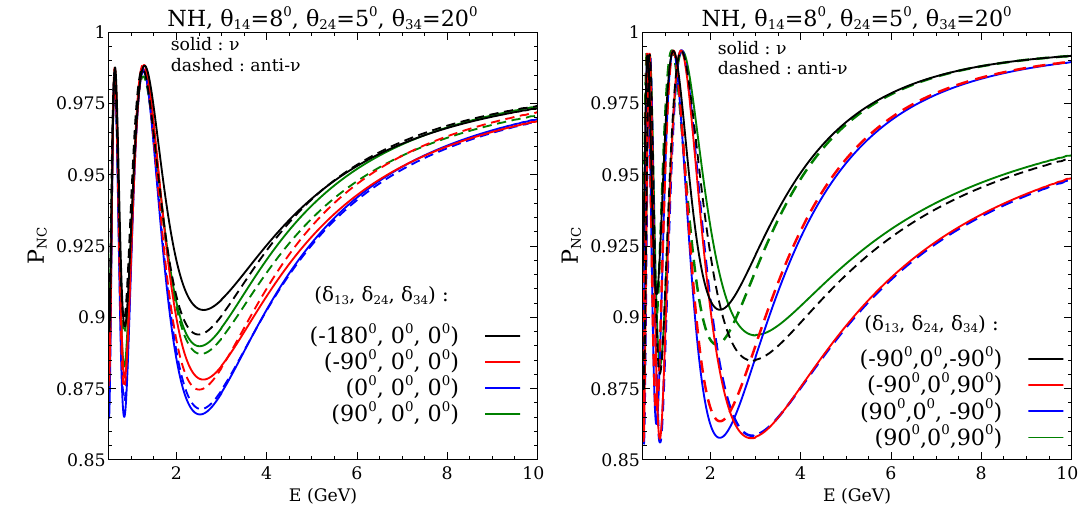
Figure 4 . P NC vs Energy (in GeV) assuming normal hierarchy for L = 1300 km in the presence of matter. (cid:18) 14 = 8 (cid:14) ; (cid:18) 24 = 5 (cid:14) ; (cid:18) 34 = 20 (cid:14) ((cid:12)xed). The solid (dashed) curves are for neutrino (anti-neutrino). Left panel: (cid:14) 13 2 f(cid:0) 180 (cid:14) ; (cid:0) 90 (cid:14) ; 0 ; 90 (cid:14) g , (cid:14) 24 = (cid:14) 34 = 0. Right panel: (cid:14) 13 ; (cid:14) 34 2 f(cid:6) 90 (cid:14) ; (cid:6) 90 (cid:14) g and (cid:14) 24 = 0 as shown in the